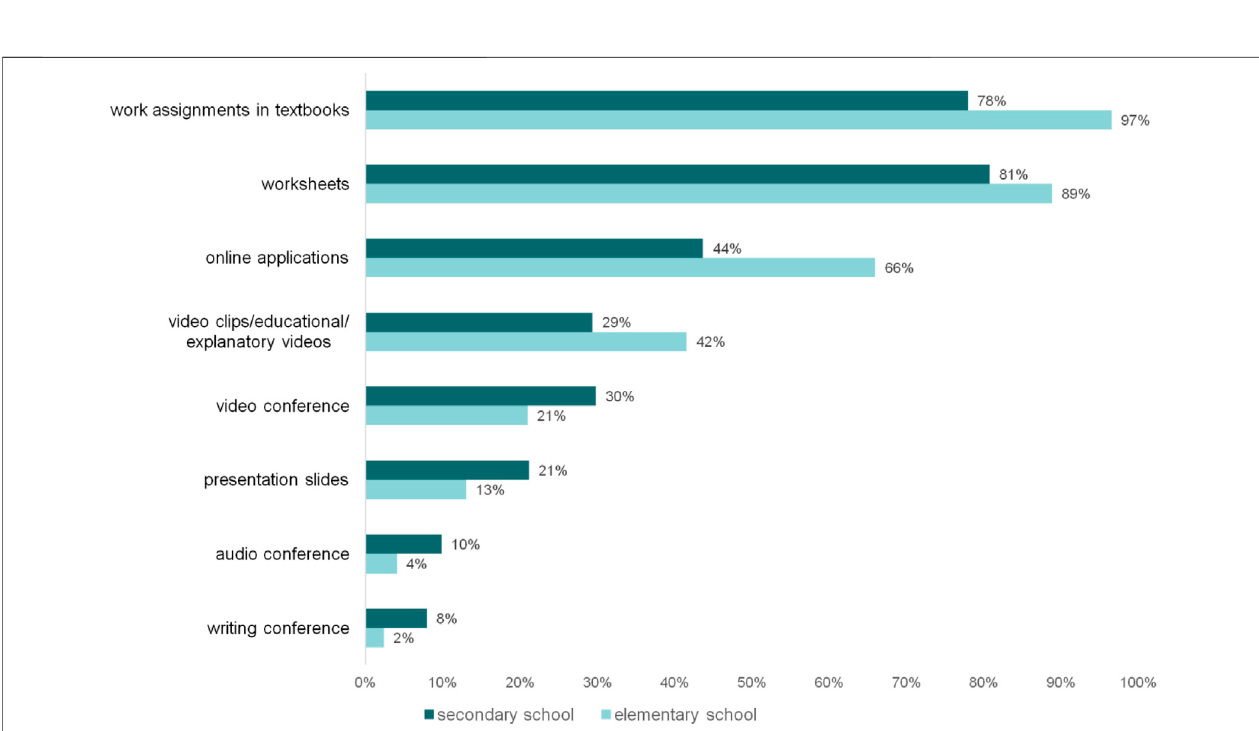
FIGURE 3 | Percentage of teachers using the indicated presentation modes for learning content at least once a week (subject German).